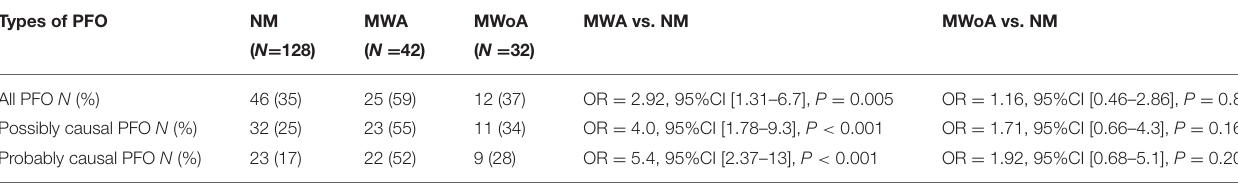
TABLE 2 | Association of PFO with MWA and MWoA. Types of PFO